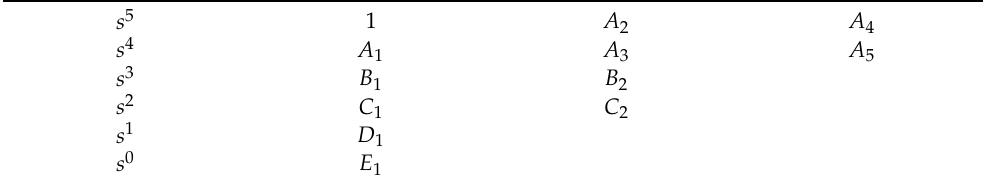
Table 2. Routh table for inverter system.